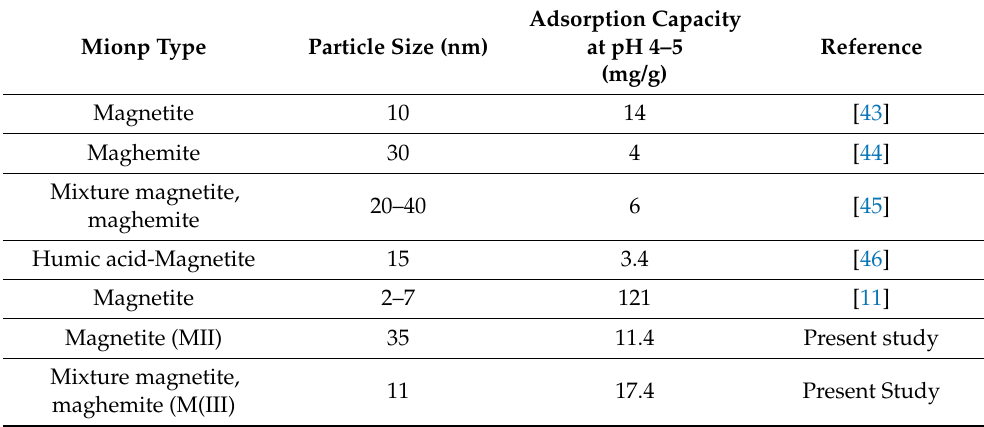
Table 3. Comparison of M(II) and M(III) performance for Cr(VI) removal with published